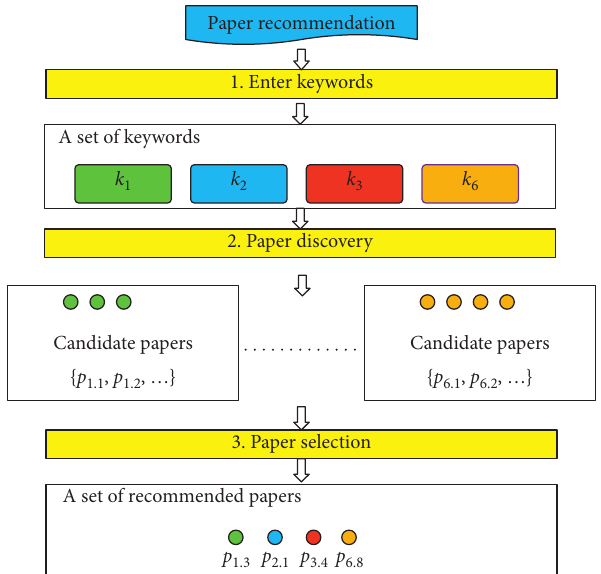
Figure 1: Paper recommendation